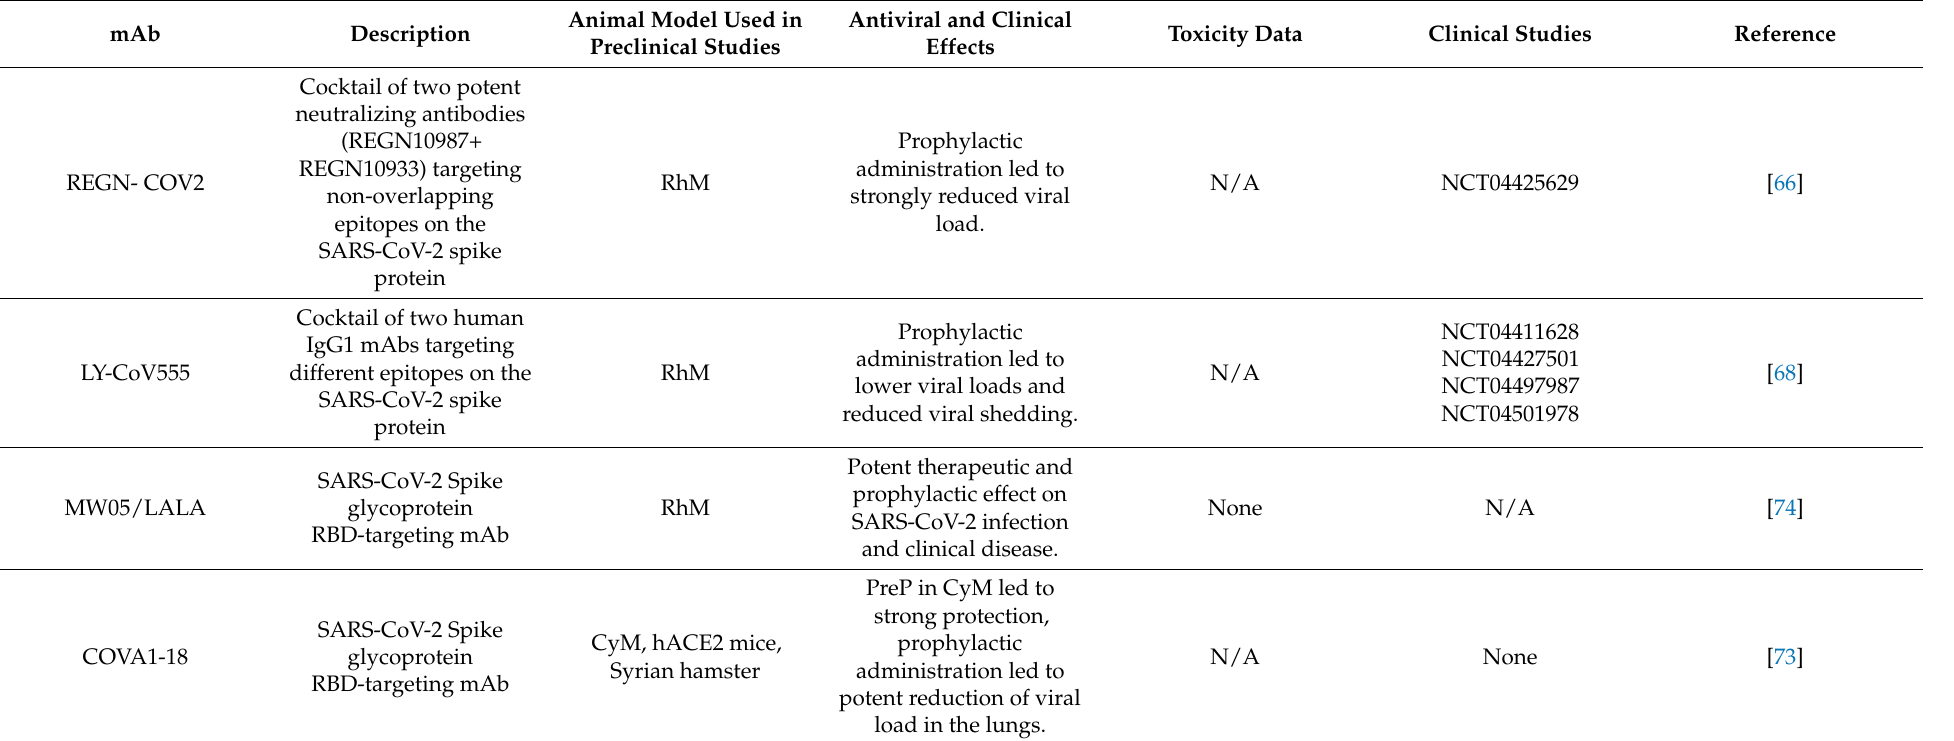
Table 3. Monoclonal antibody therapies against SARS-CoV-2 infection tested in NHP